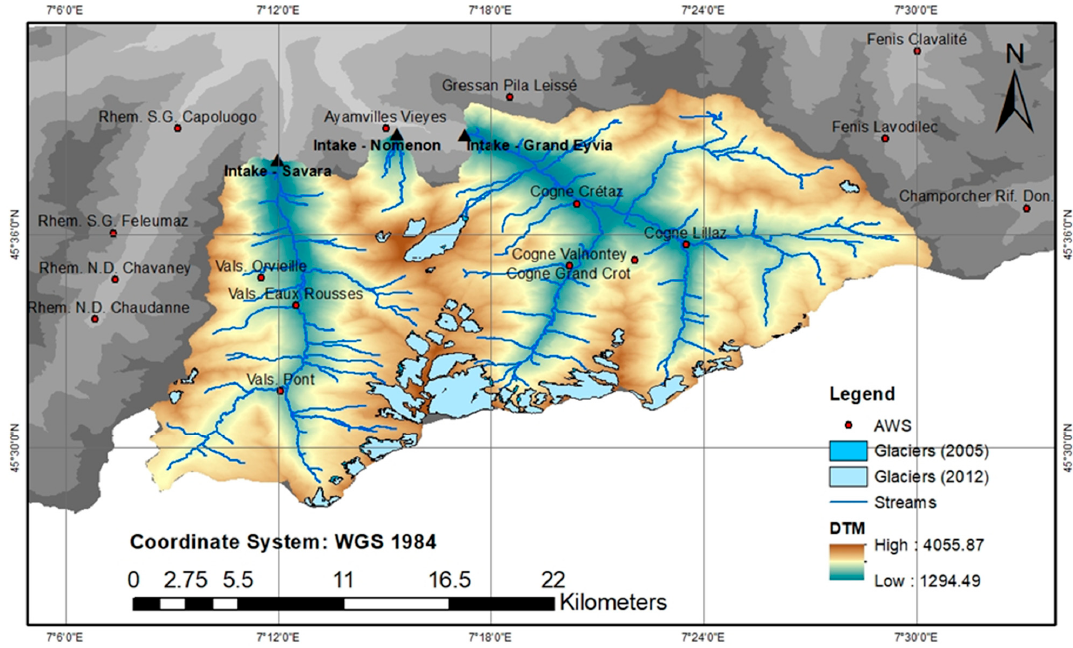
Figure 1. Chavonne plant’s catchment, streams, and glaciers’ outline (2005 and 2012). Automated weather stations (AWS)s used to retrieve meteorological records for Poli-Hydro. Figure prepared by the authors using ArcMap. Table 1. Val di Cogne and Valsavarenche, coordinates of the AWS stations for temperature, precipitation, radiation and discharge. The data were made available by the Centro Funzionale Regione Autonoma Valle D’Aosta, CFVDA. T is temperature, P l is liquid rainfall, H is heated gauge, S is snow depth, R is solar radiation, W is water level (streamflow).